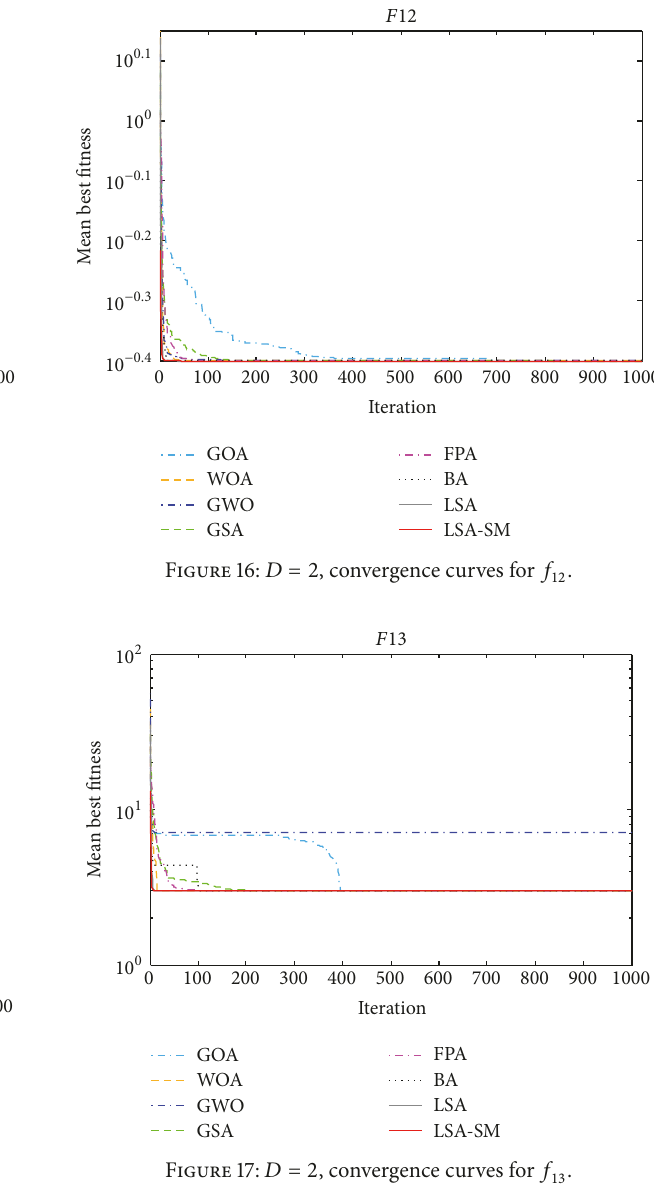
Figure 15: 𝐷 = 4 , convergence curves for 𝑓 11 .